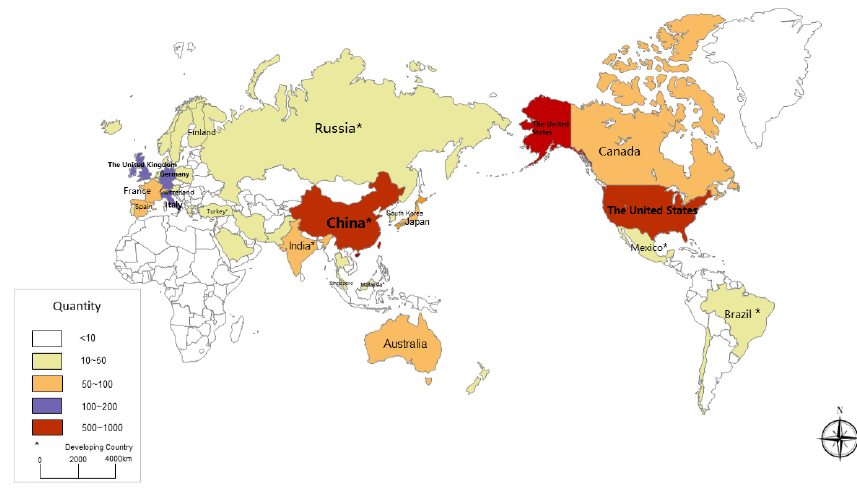
Figure 3. Spatial distribution of global publications.